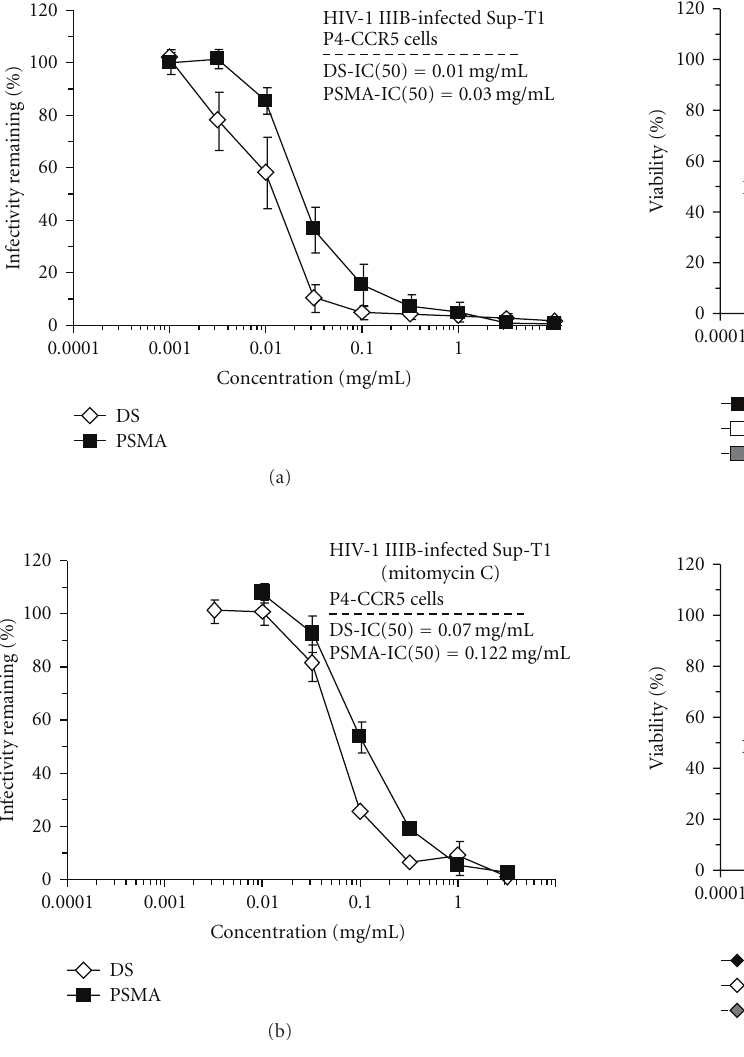
Figure 3: alt -PSMA inhibits infection of P4-R5 MAGI cells by HIV- 1-infected cells. (a) HIV-1 strain IIIB-infected Sup-T1 T cells were incubated for 10min in the absence or presence of alt -PSMA or DS prior to 1 :10 dilution and incubation with P4-R5 MAGI cells for 2 h (as described in Section 2). (b) Mitomycin C-treated HIV- 1 strain IIIB-infected Sup-T1 T cells were incubated for 2min in the absence or presence of alt -PSMA or DS prior to 1: 10 dilution and incubation with P4-R5 MAGI cells for 2 h (as described in Section 2). Infectivity remaining was expressed relative to mock- treated, HIV-1-infected cells and graphed against the compound concentration achieved during the 2-h incubation with P4-R5 MAGI cells. Each concentration was examined in triplicate in two independent assays.